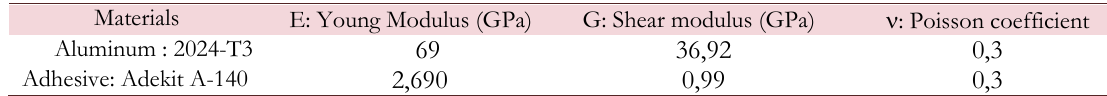
Table 2: Elastic properties of the Aluminum plate and adhesive